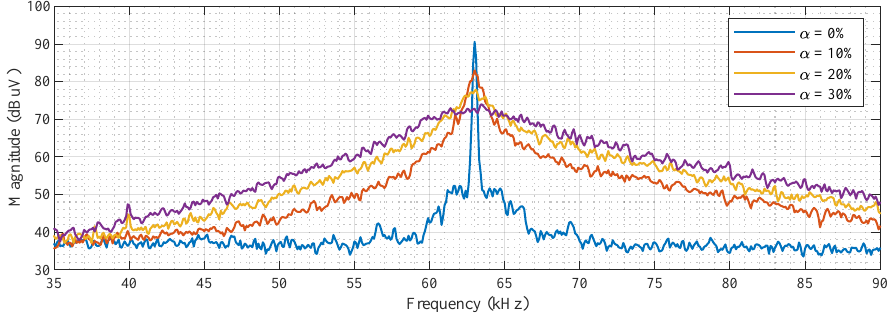
Figure 7. The spectrum of SSM EMI measured from the PLC